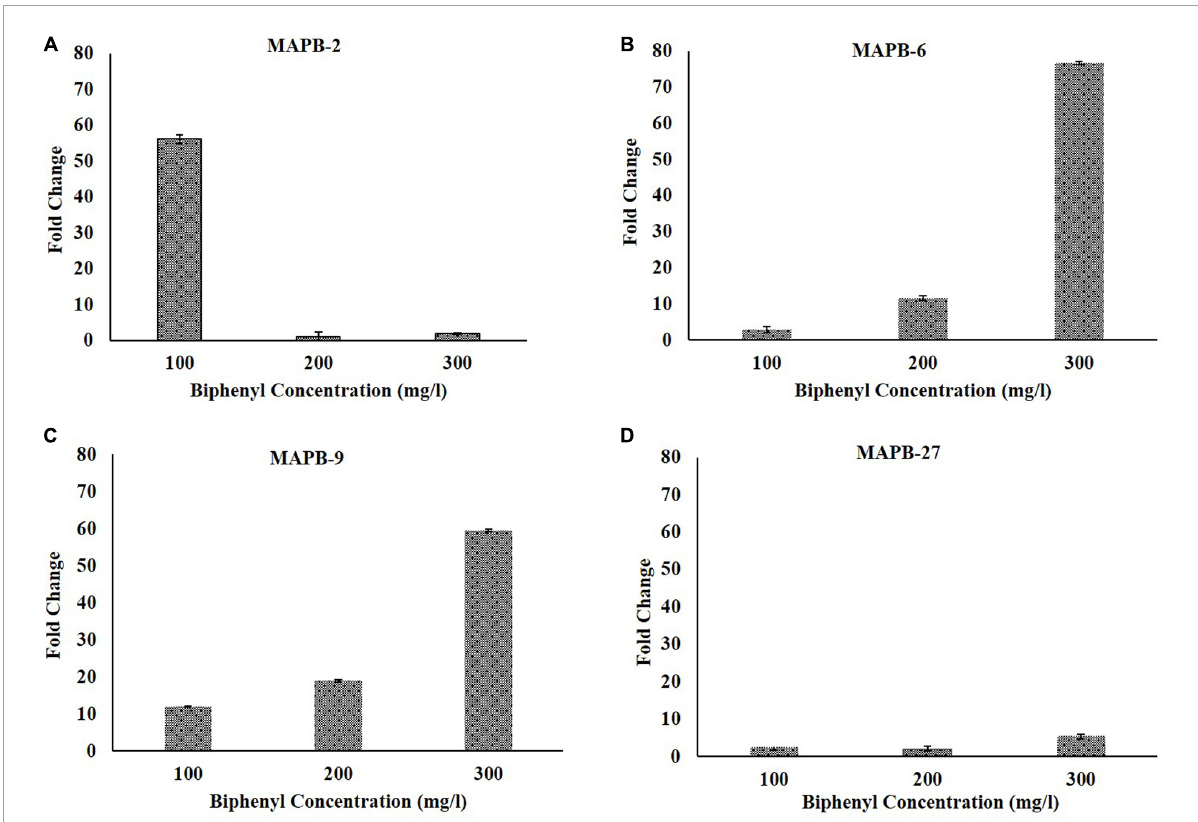
FIGURE3 Gene expression of ARHD with increasing concentration of biphenyl at 100, 200, and 300 mg/l. (A) MAPB-2, (B) MAPB-6, (C) MAPB-9, and (D)